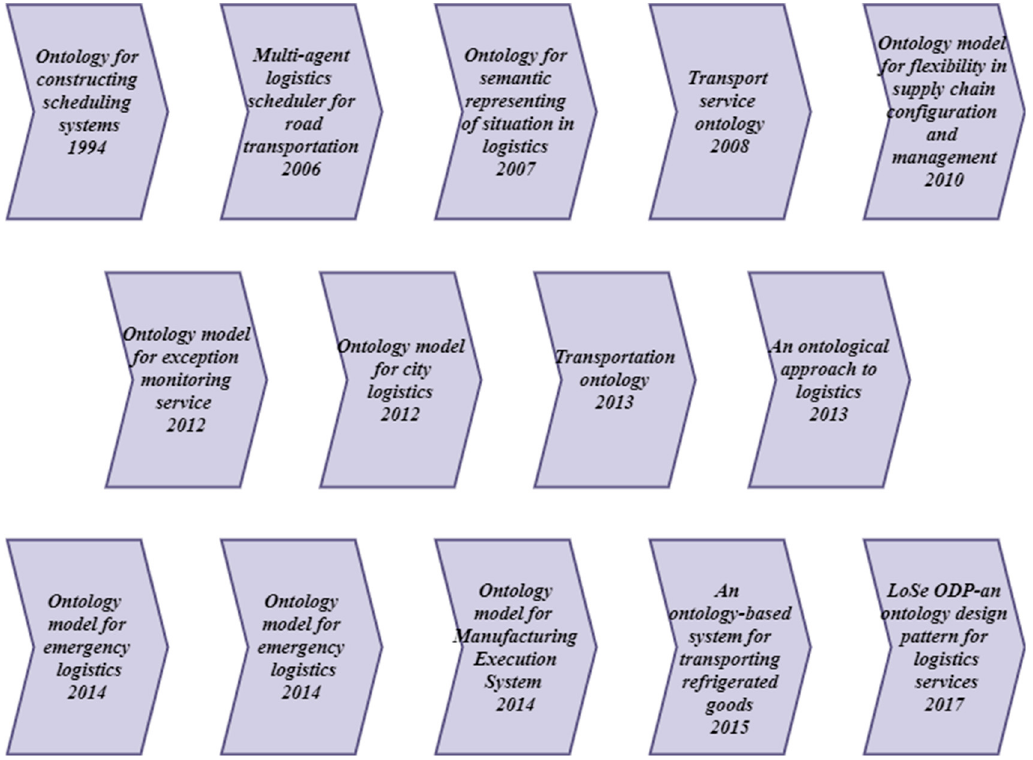
Figure 1. Overview of ontology systems used in logistics.